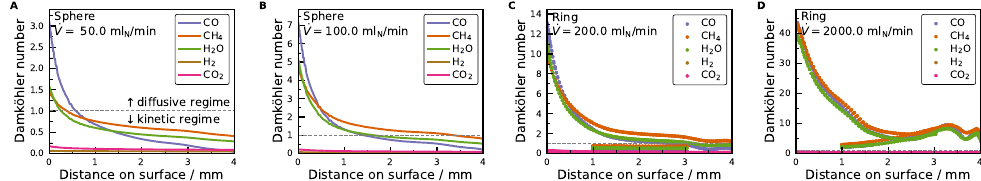
Figure 6. Damköhler number for ( A , B ) sphere and ( C , D ) ring in Temkin single chamber. ( A ) − 1 , ( B ) ˙ V = 100 ml − 1 , ( C ) ˙ V = 200 ml − 1 , and ( D ) ˙ V = 2000 ml ˙ V = 50 ml N min N min N min